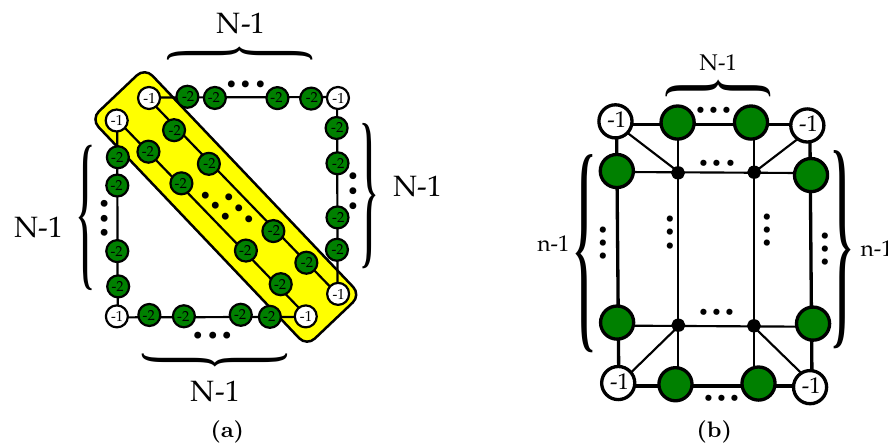
Figure 7 . (a) Gluing of two T N along the diagonal. The nodes in the yellow box corresponding to SU( N ) (cid:13)avor are gauged and identi(cid:12)ed. (b) An example of a toric model, with (cid:13)avor SU( N ) 2 (cid:2) SU( n ) 2 , which for N = n corresponds to the gluing in